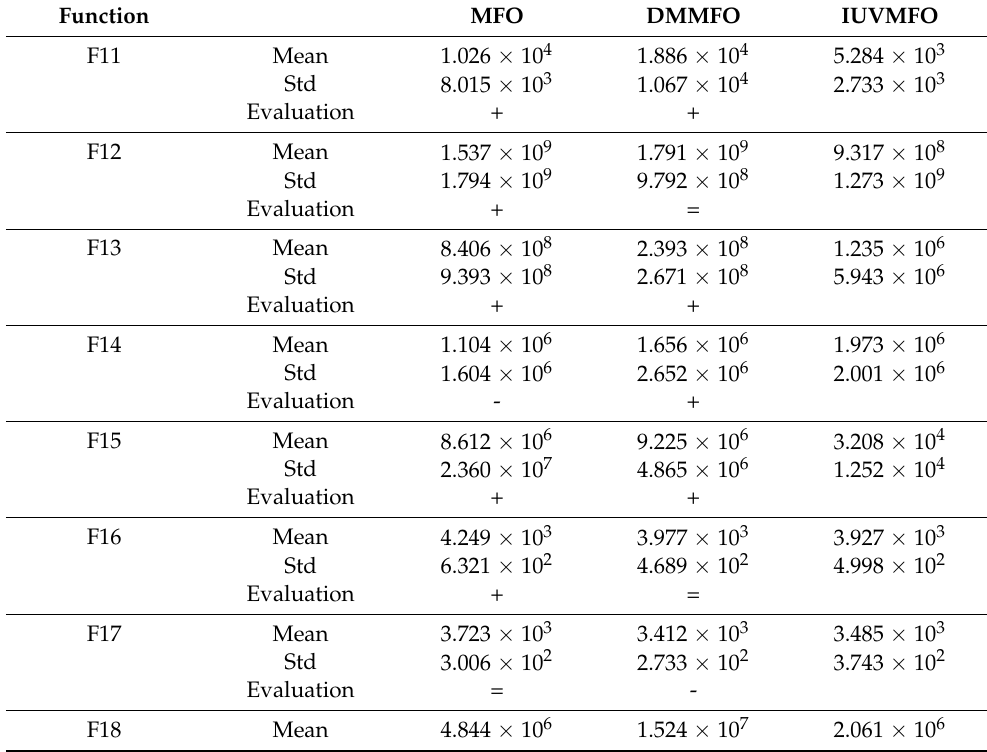
Table A5. Statistics of 50-dimensional Function Test